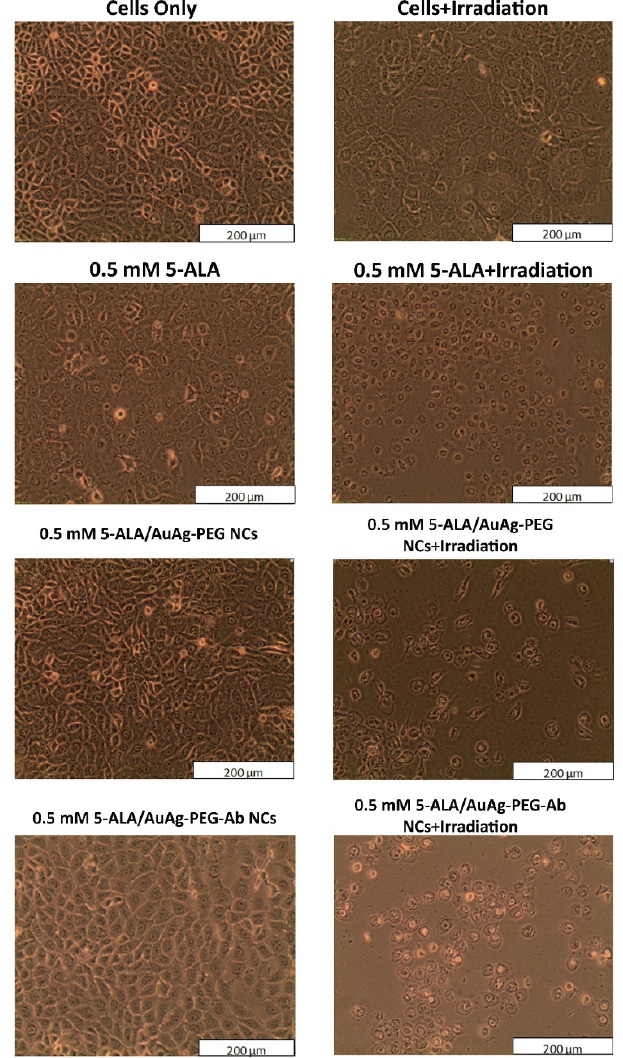
Figure 3. Light microscopy images for PDT-treated and non-treated MCF-7 cells with free 5-ALA, the NCs, and laser light irradiation under the IC50 concentration of 5-ALA at a wavelength of 636 nm and a fluency of 5 J/cm 2 .